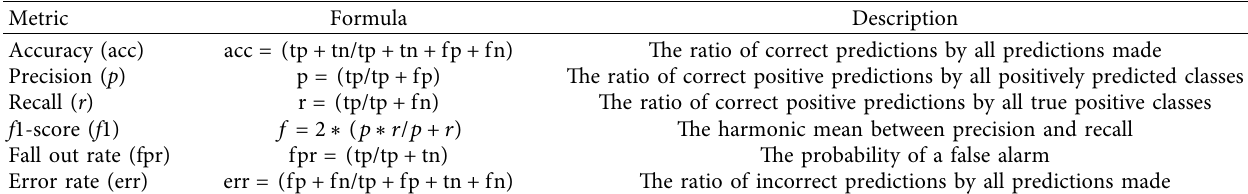
Table 1: Common classifcation model evaluation metrics in the equipment reliability context.